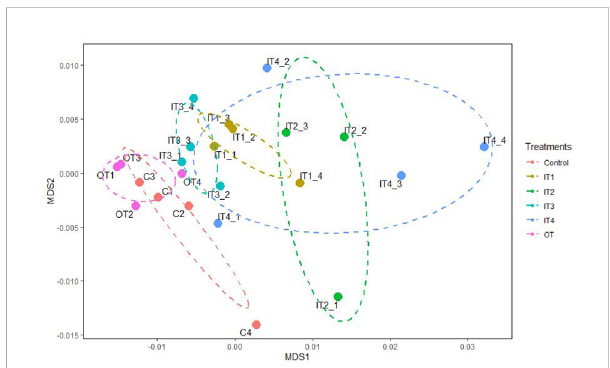
FIGURE 3 Non-metric multidimensional scaling (NMDS) analysis on a Bray- Curtis dissimilarity matrix based on the predicted functional pathway pro fi les associated with the bacterial communities of